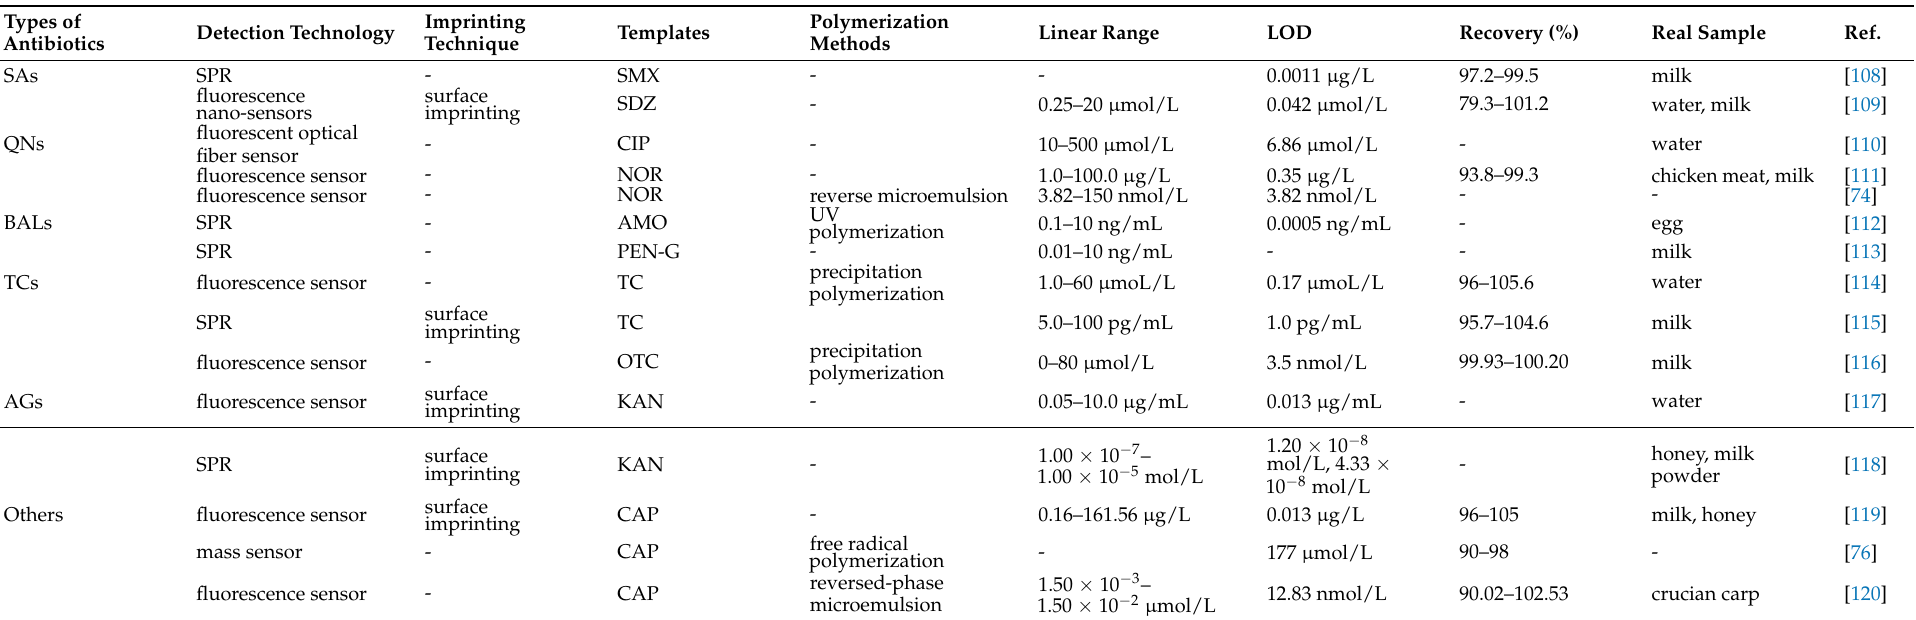
Table 3. Application of MIPs based optical and mass sensors in antibiotic